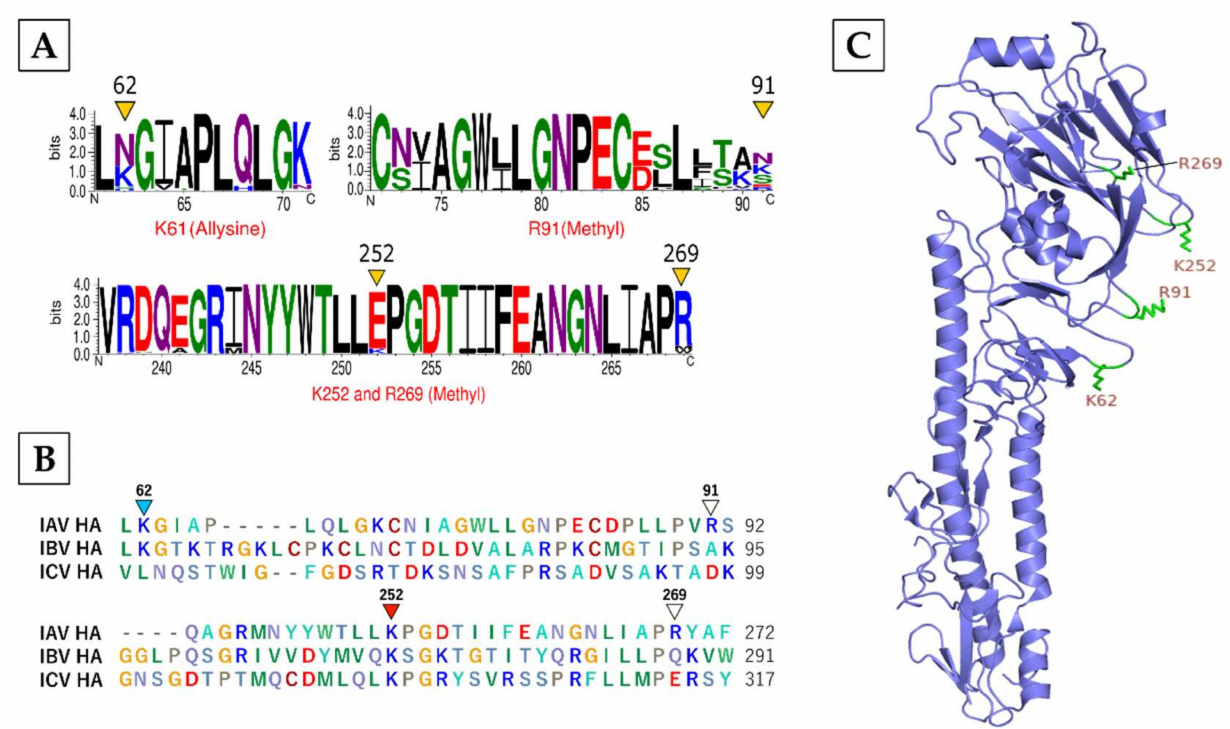
Figure 5. The characteristics of the modifications on IAV hemagglutinin (HA). ( A ) Conservation of modified residues across HA of IAV H1 subtypes. A total of 480 sequences from 7 different IAV H1 subtype strains were aligned in BioEdit using ClustalW and visualized by WebLogo. The logos represent individual peptides with modified residues (yellow arrowheads). The X -axis indicates the position of amino acid and the Y -axis indicates the bit score on a scale of 1–4 (A scale of 4 means 100% conservation). Methyl: methylation. ( B ) Conservation of modified residues across HA of IAV, IBV, and ICV. Red arrowheads point to conservation in all three influenza virus types, turquoise arrowheads point to conservation in IAV and IBV, and white arrowheads point to no conservation. ( C ) Location of modified residues in the HA structure. Green atom stick indicates the location on loop